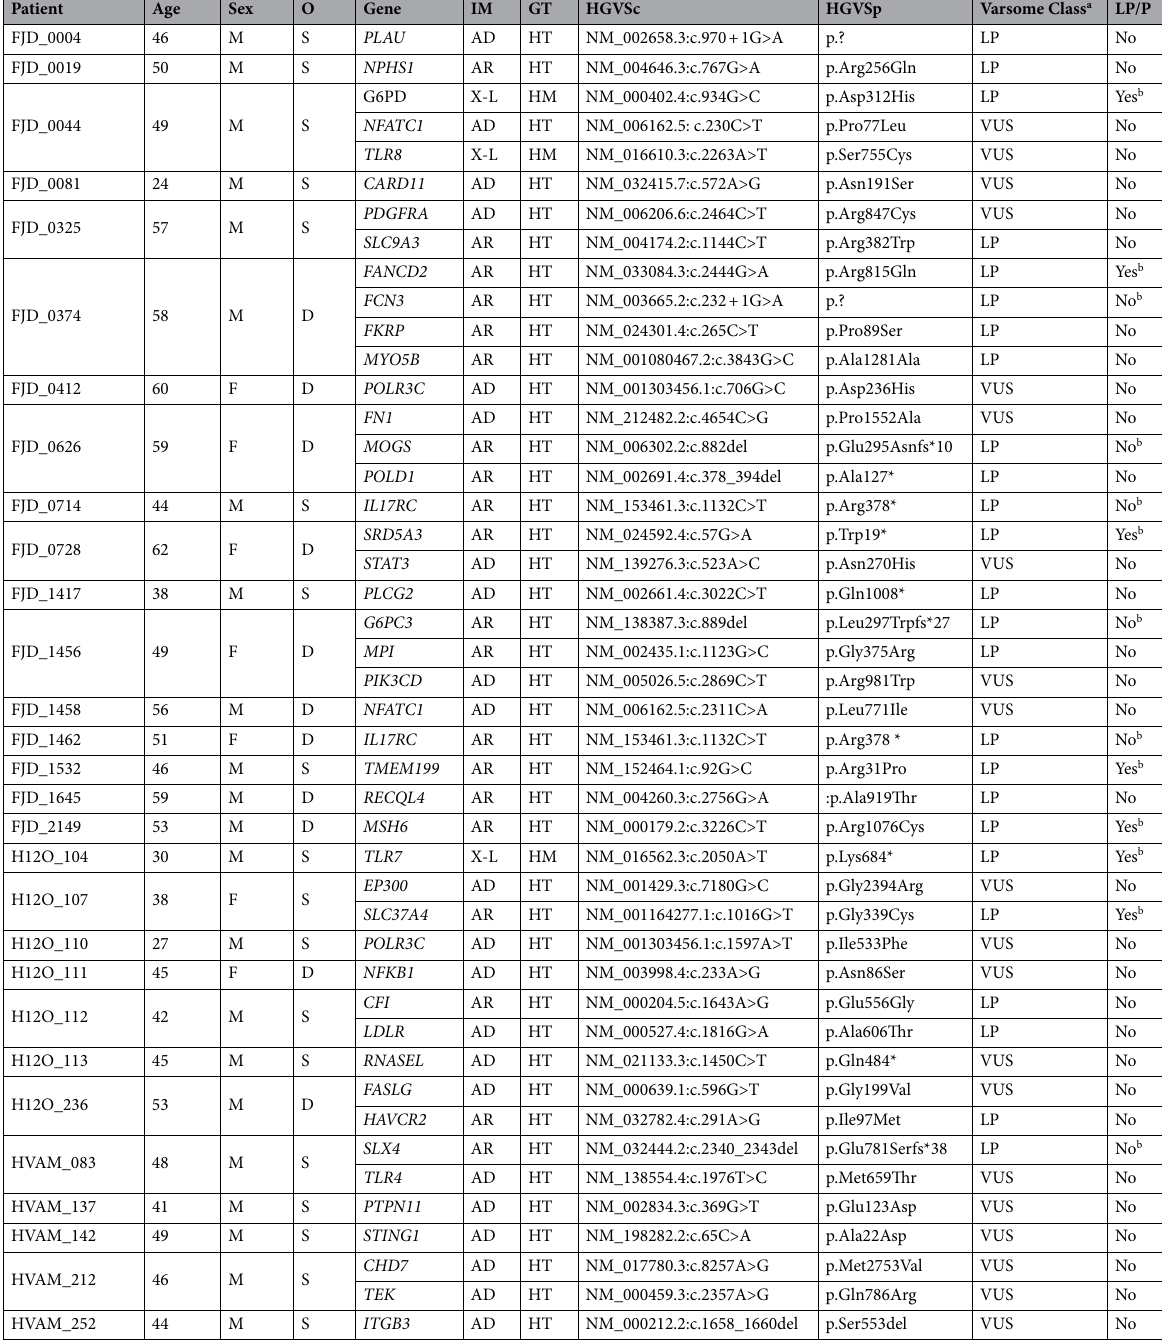
Table 2. List of filtered candidate variants identified in our cohort of COVID-19 patients. M male, F female, O Outcome, D deceased, S survivor, IM inheritance mode, AD autosomal dominant, AR autosomal recessive, X-L linked to X chromosome, GT genotype, HT heterozygous, HM Hemizygous, Chr chromosome, HGVSc HGVS coding sequence name, HGVSp HGVS protein sequence name, LP likely pathogenic, P pathogenic, VUS variant of unknown significance. a Varsome class followingACMG criteria; b variants previously described as likely pathogenic or displaying strong evidence for being considered as likely